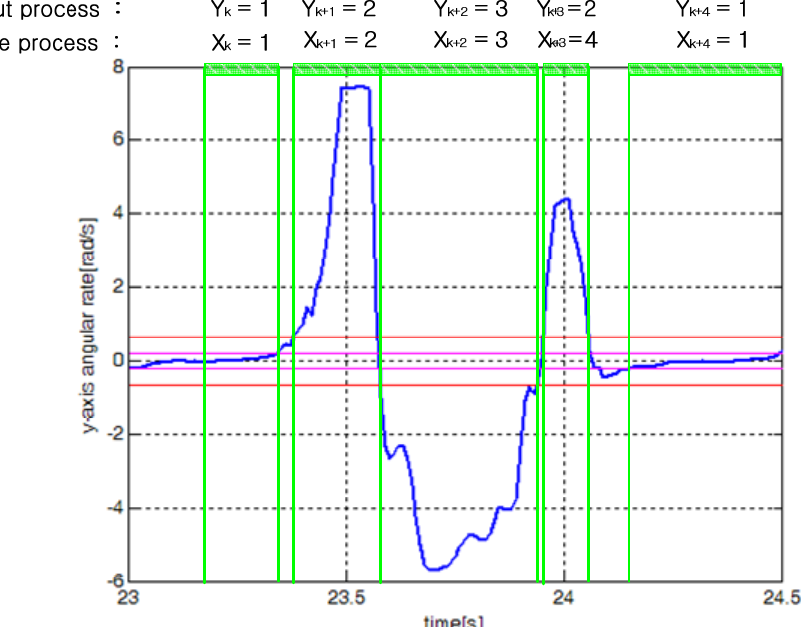
Figure 7. State transition example of normal walking cycles.